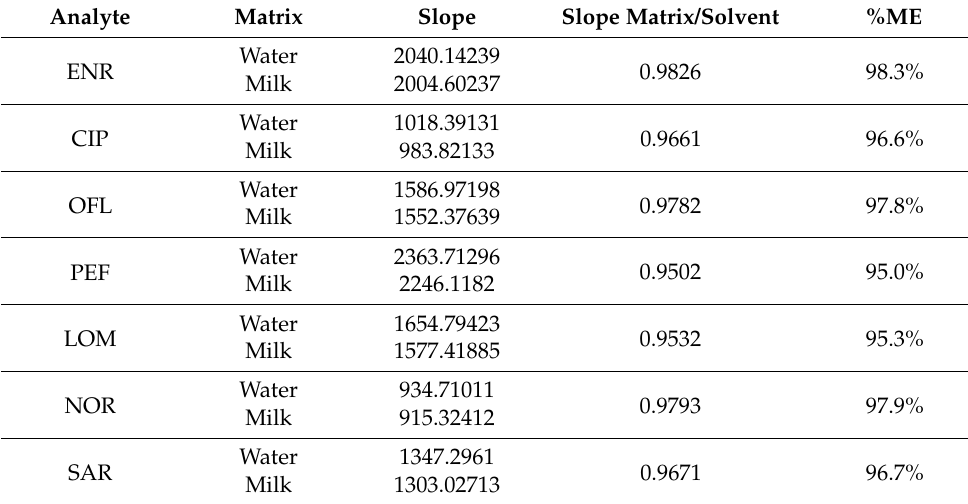
Table 4. Evaluation of matrix effect with comparison of calibration-curve